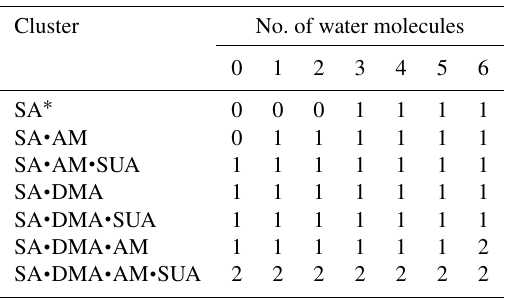
Table 4. Number of proton transfers within hydrated clusters ( T = 298 .